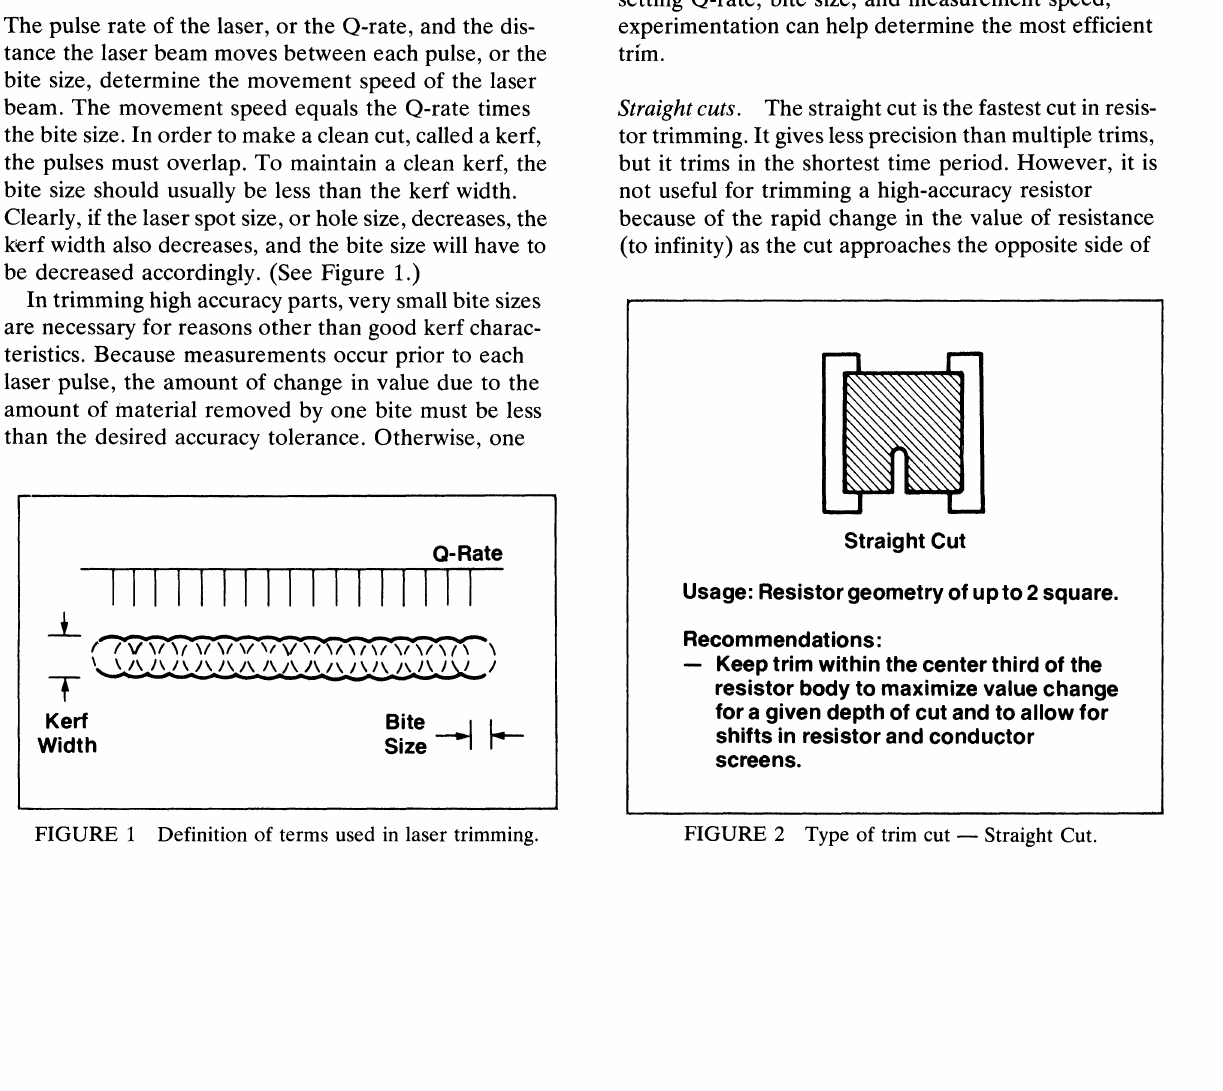
Definition of terms used in laser